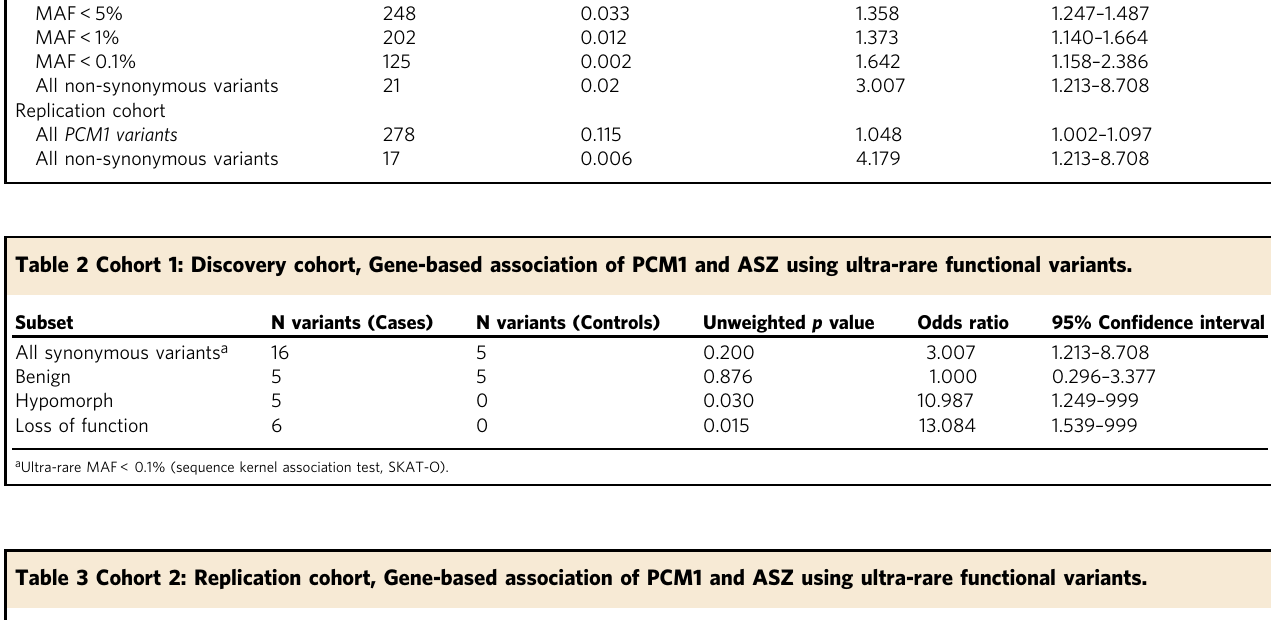
Table 3 Cohort 2: Replication cohort, Gene-based association of PCM1 and ASZ using ultra-rare functional variants. Subset N variants (Cases) N variants (Controls) All synonymous variants a Benign